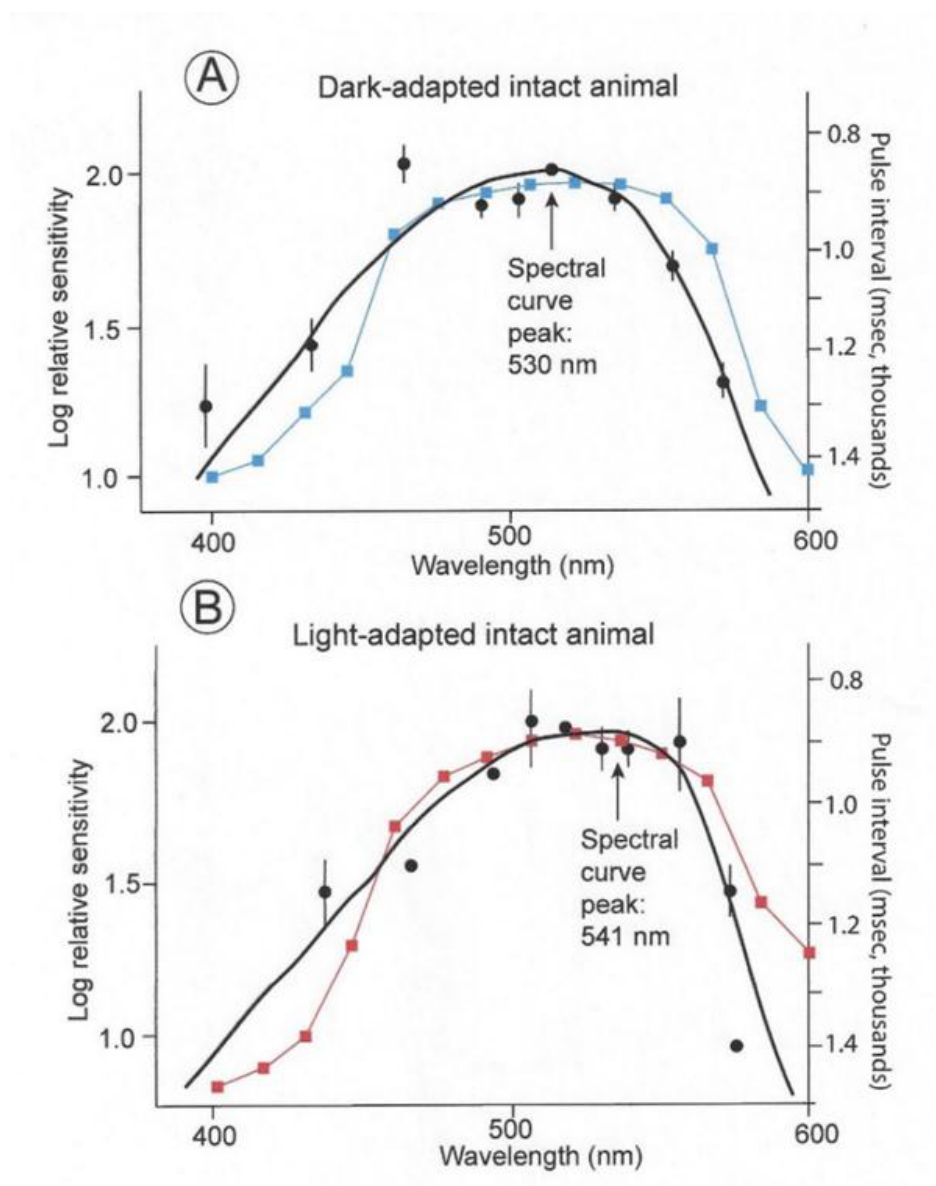
Figure 7. Spectral curves of six dark- and light-adapted lemon sharks (black curves) [18]. Superim- posed are the spectral sensitivity curves of the photocells with gel filters used to record measurements of irradiance perceived by dark- (blue) and light-adapted (red) lemon sharks. Note that the sensitivities were normalized to emphasize spectral differences, with the dark-adapted measurements being for intensities’ multiple log units less than the light-adapted measurements. The lemon shark’s maximum sensitivity in a spectral curve is evident with a peak at 530 nm if kept in the dark prior to the threshold experiment. On the contrary, a shark kept in daylight has a broadened sensitivity range that is shifted 21 nm toward the red with a peak sensitivity of 541 nm. This effect is termed the Purkinge shift